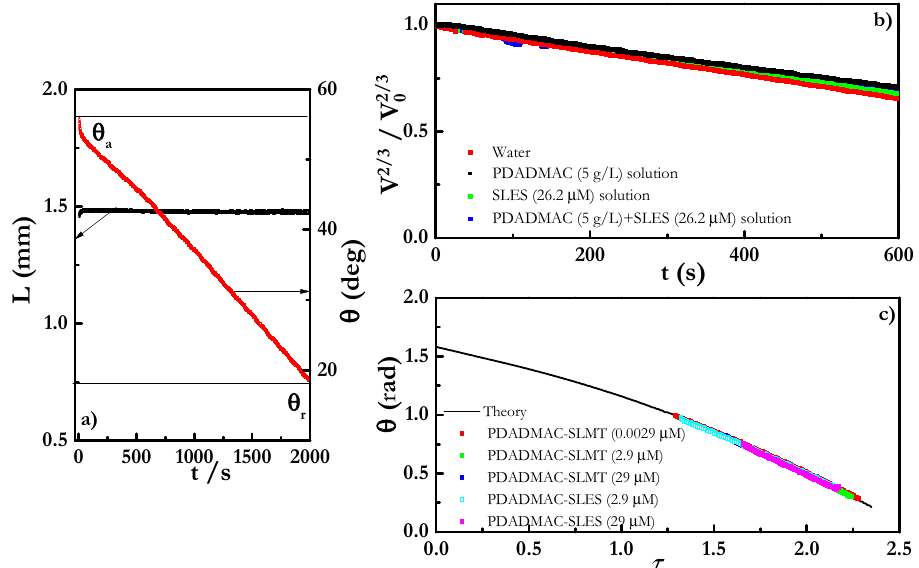
Figure 8. ( a ) Time dependence of the contact angle θ and the contact length L for a sessile droplet of PDADMAC–SLES mixture ((SLES) = 2.62 µM ) during evaporation on a silicon wafer at relative humidity of 60%. ( b ) Plots of V 2/3 / V 0 2/3 vs. time for evaporating a sessile droplet on a silicon wafer at a relative humidity of 60%. ( c ) Dependence of the contact angle θ on the dimensionless time (cid:101) τ for the evaporation of different polyelectrolyte–surfactant mixtures, with a PDADMAC concentration of 5 g/L, at a relative humidity of 60%. The solid line is the theoretical solution to the equation for the first evaporation stage, obtained according to Semenov et al. [39] .